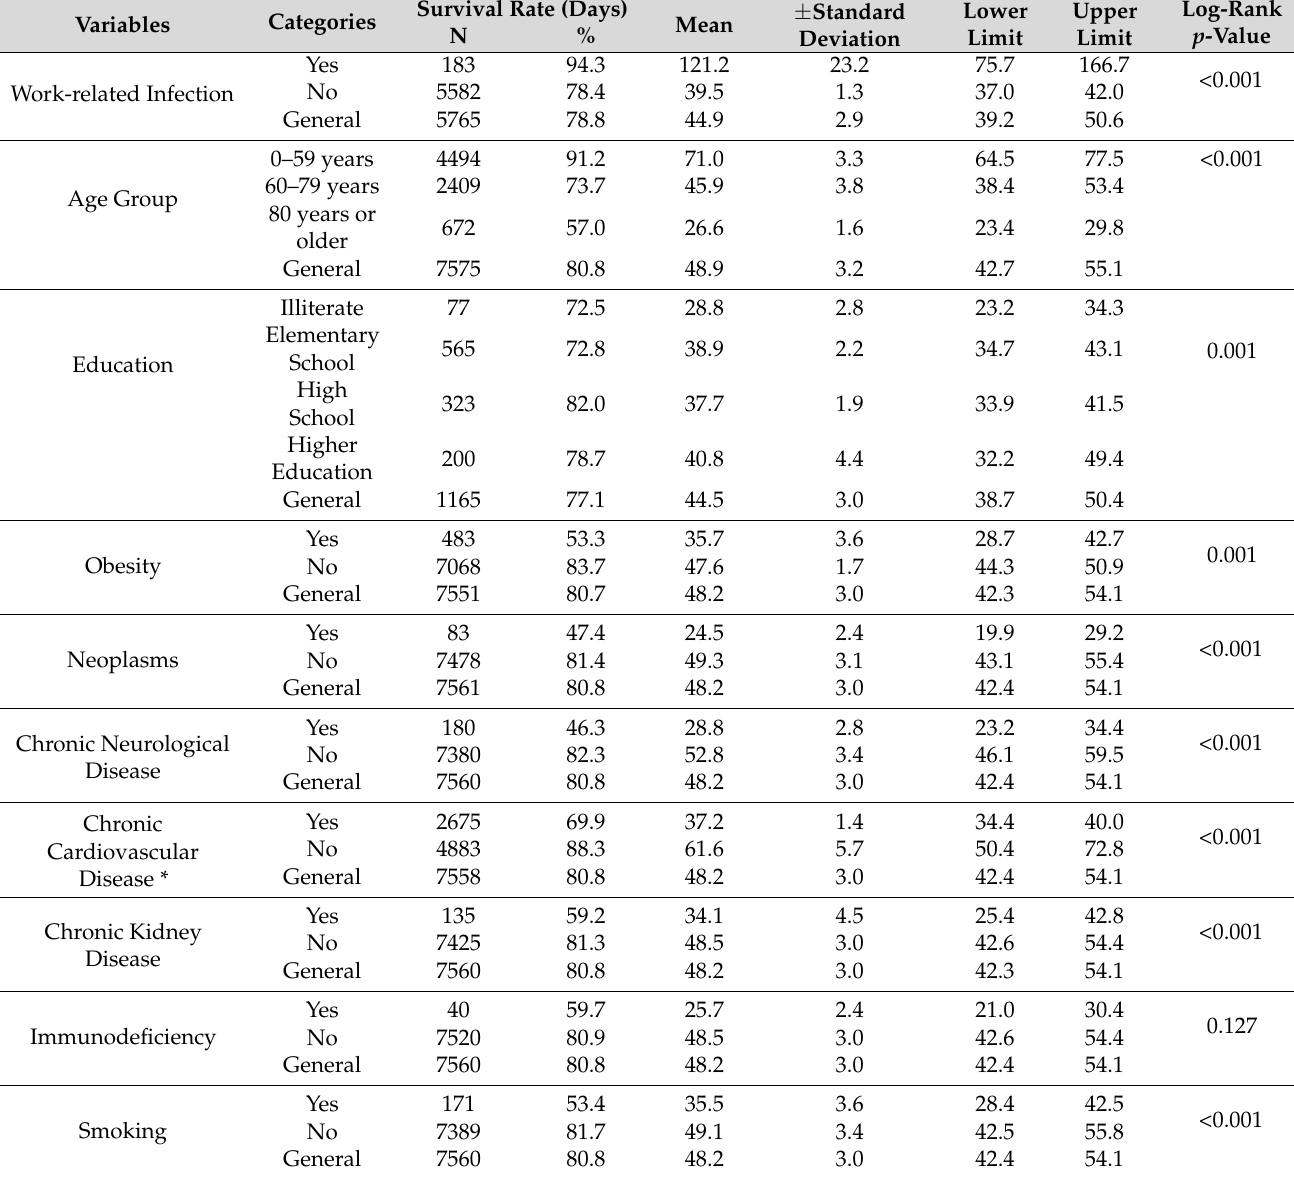
Table 4. Univariable survival for the outcome of death from COVID-19 (Kaplan Meier and Log-Rank test) in hospitalized patients in Esp í rito Santo, Brazil, in the period from 1 March 2020 to 31 July